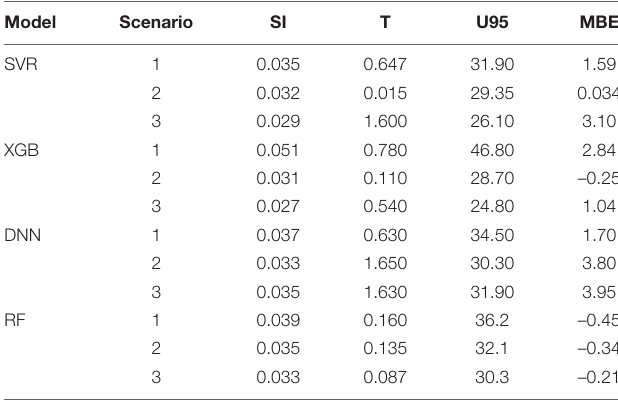
TABLE 3 | The performance statistics of support vector regressor (SVR), extreme gradient boosting (XGB), deep neural network (DNN), and random forest (RF) models for